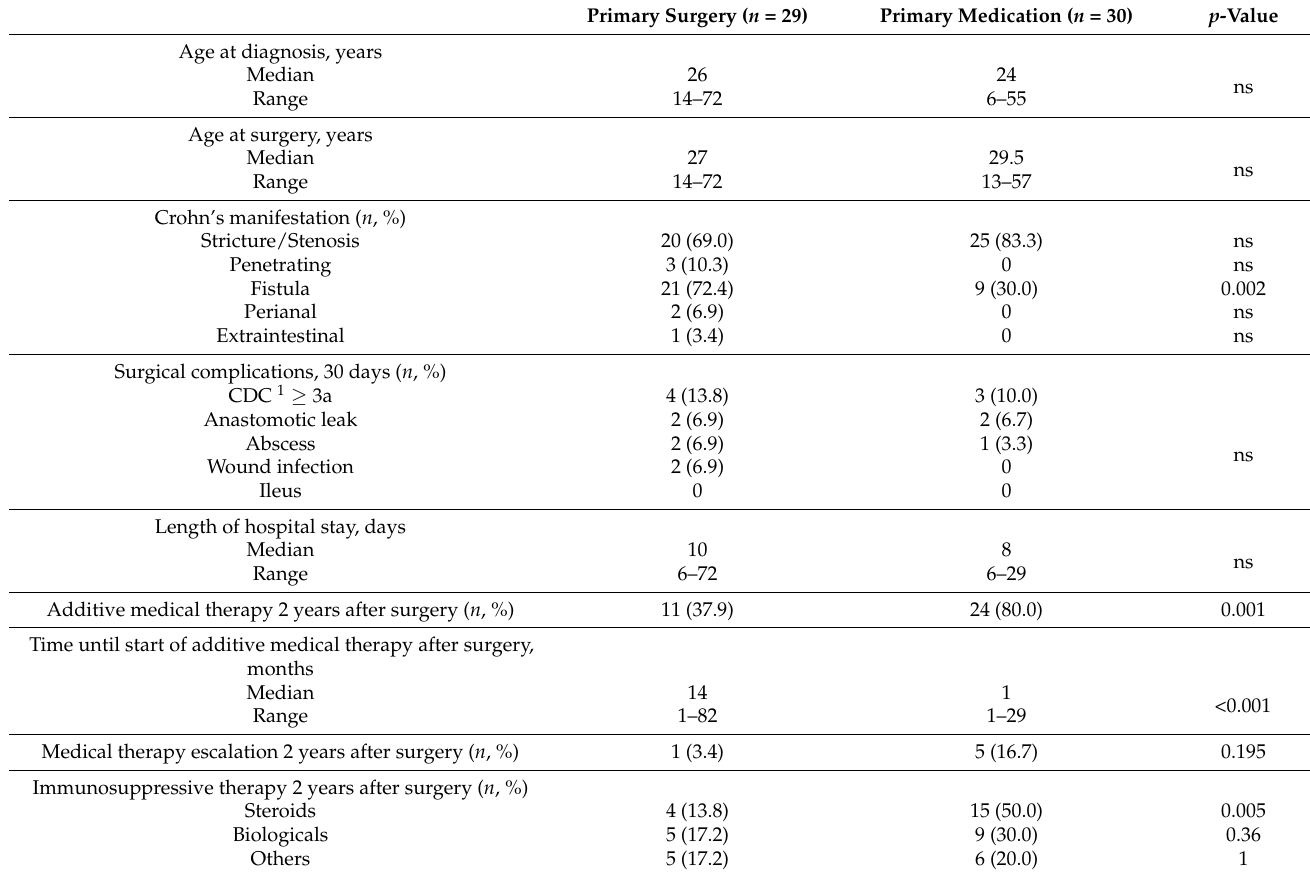
Table 3. Postoperative outcome in patients with localized (ileocecal)